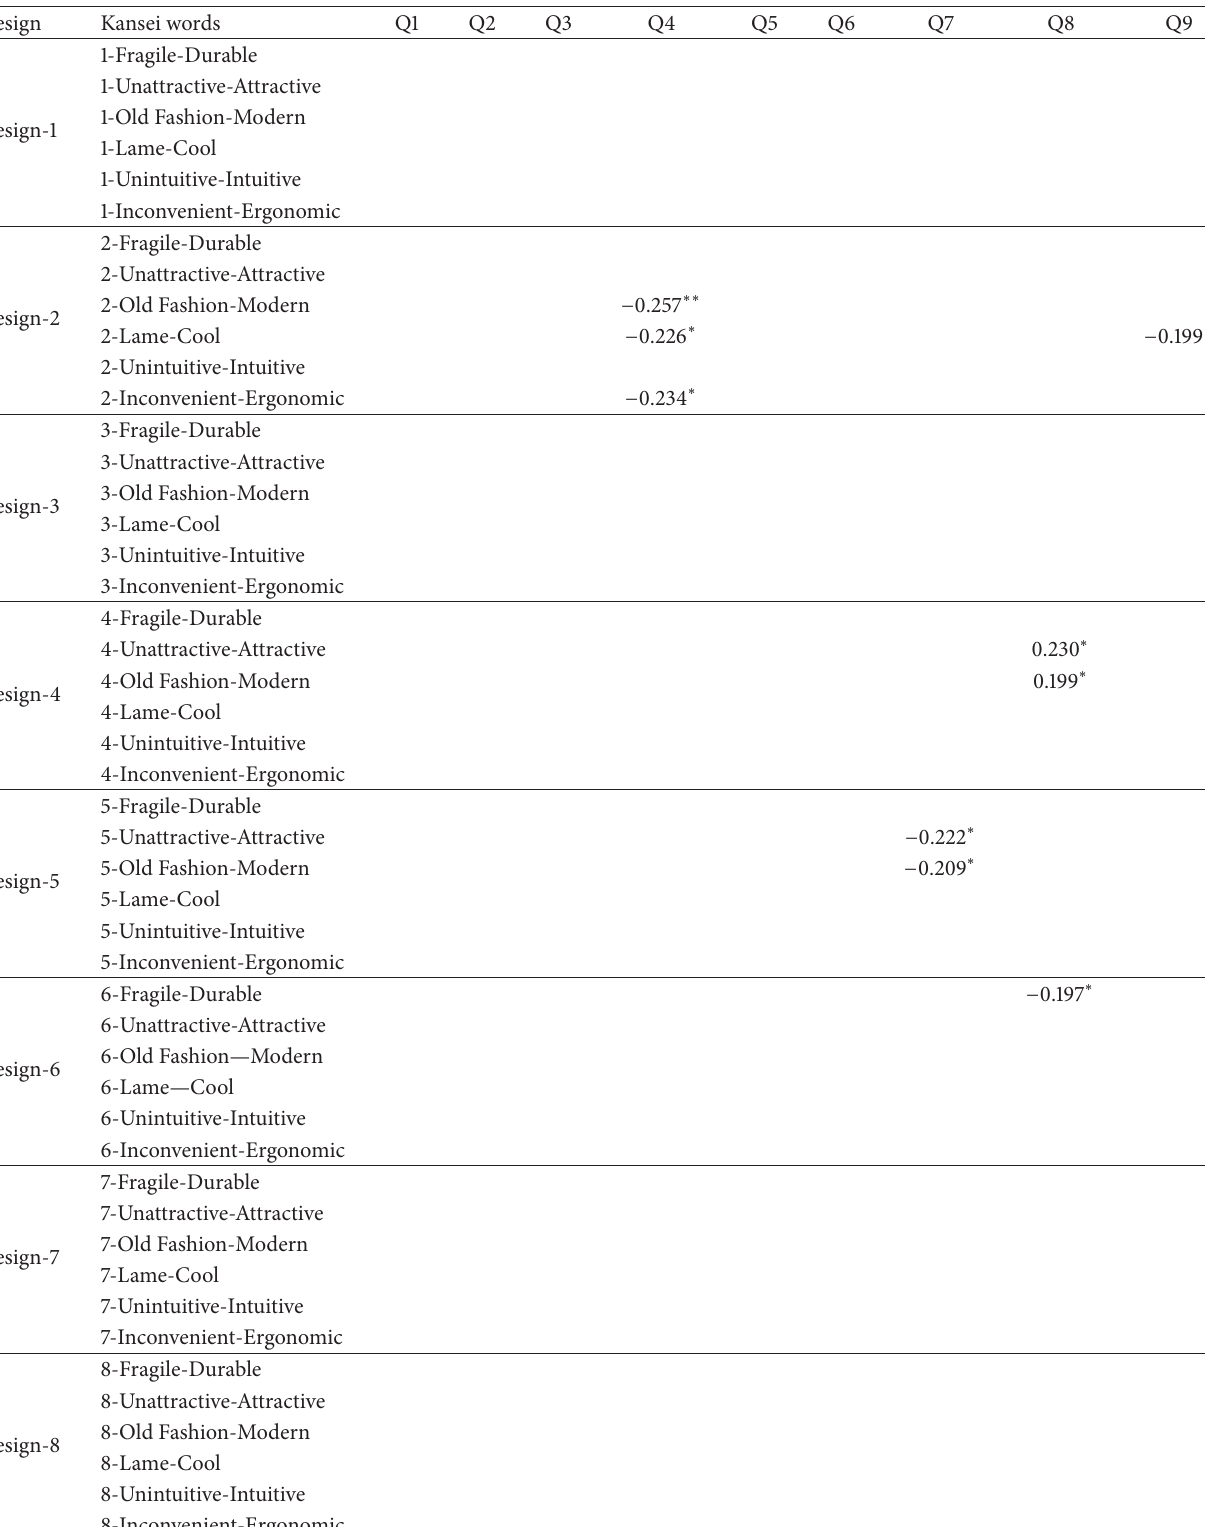
Table 11: Correlation between design proposed toward cognitive alert